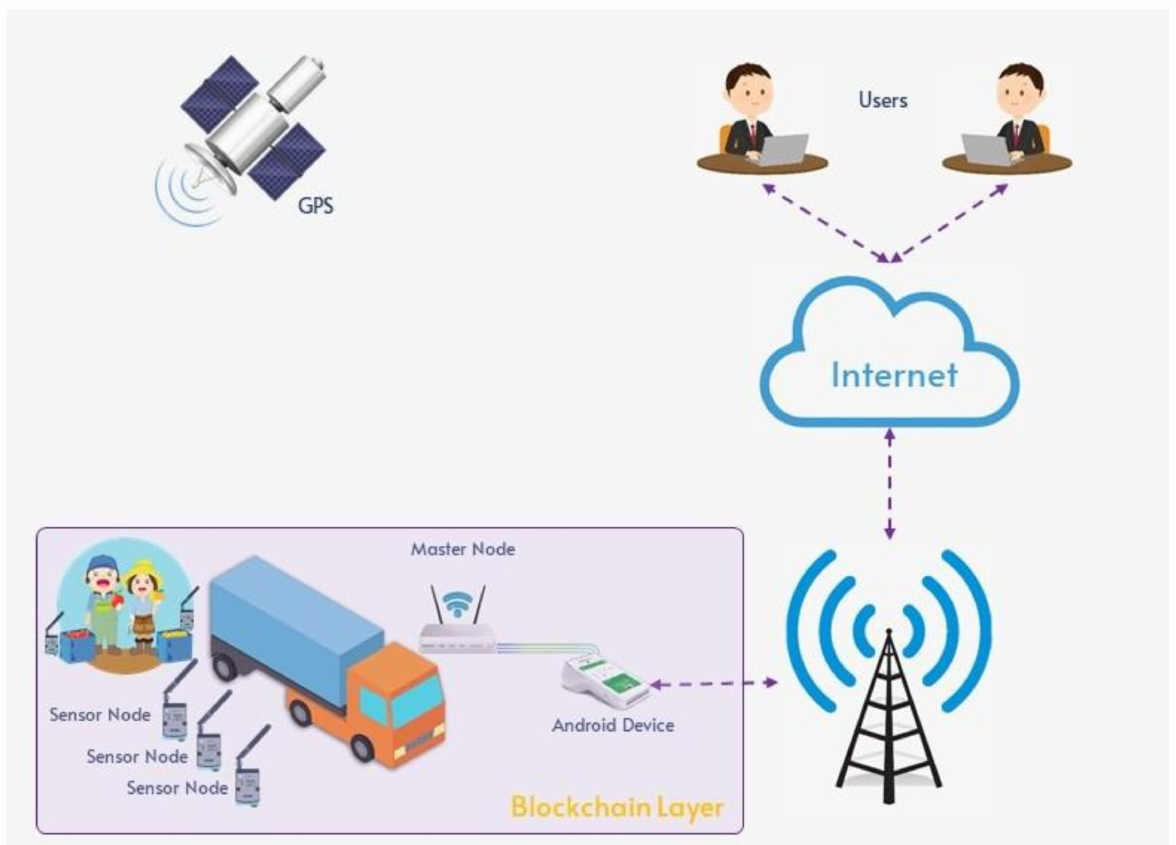
Figure 6. Proposed system components and transaction flow for real-time food supply tracking and